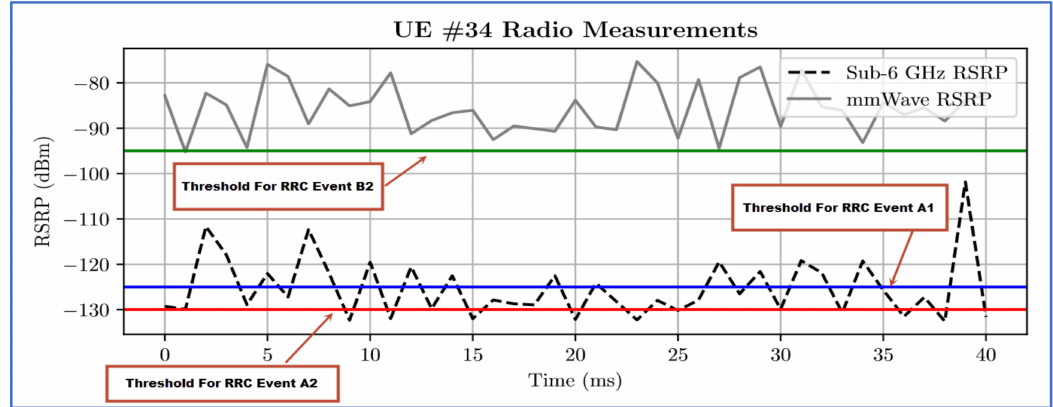
Figure 5. RSRP of UE#34. On X -axis, blue, red, and green lines represent the thresholds of RRC events A1, A2, and B2, respectively.